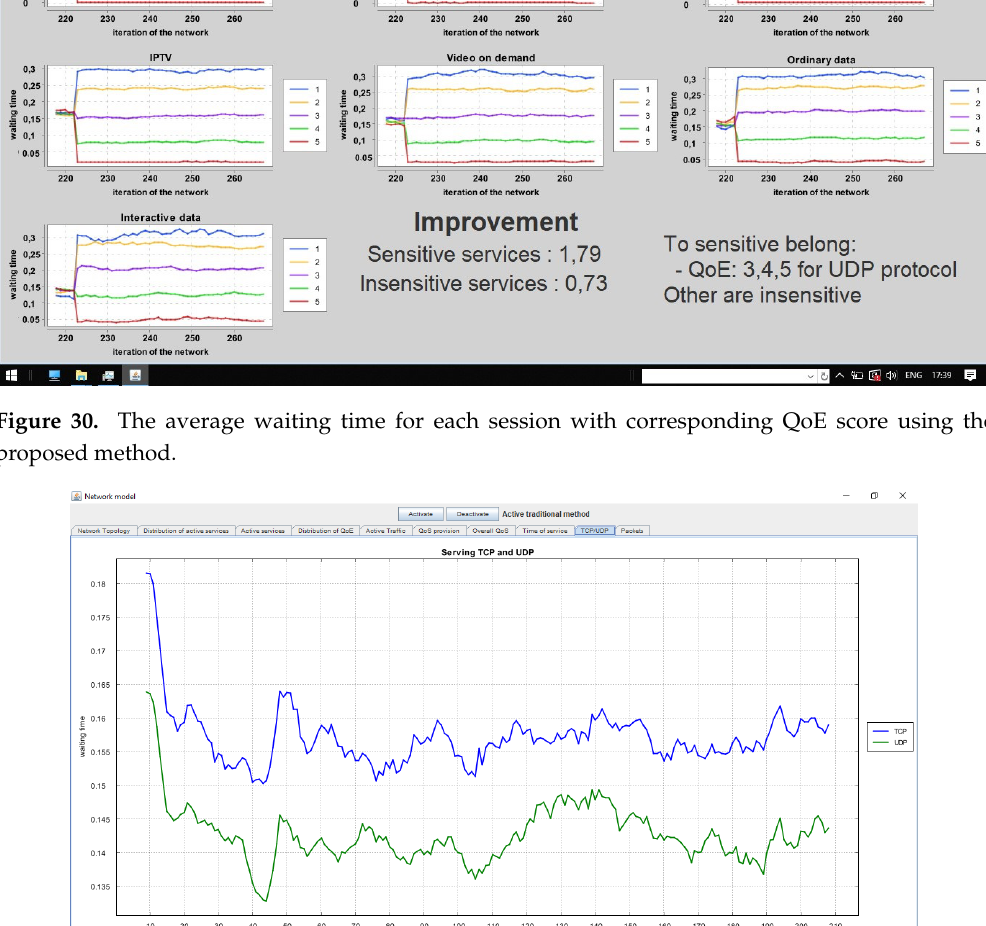
Figure 29. Customer satisfaction according to QoE ratings using the proposed method.